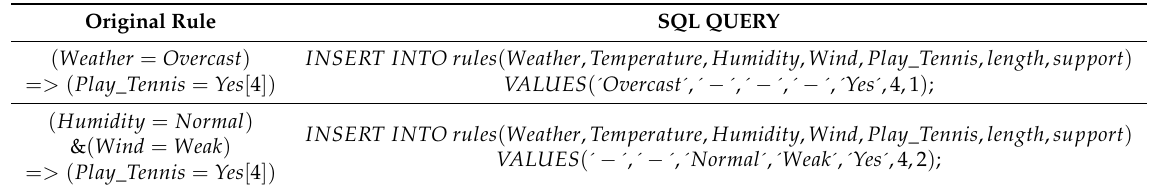
Table 6. An example of how to upload rules into the